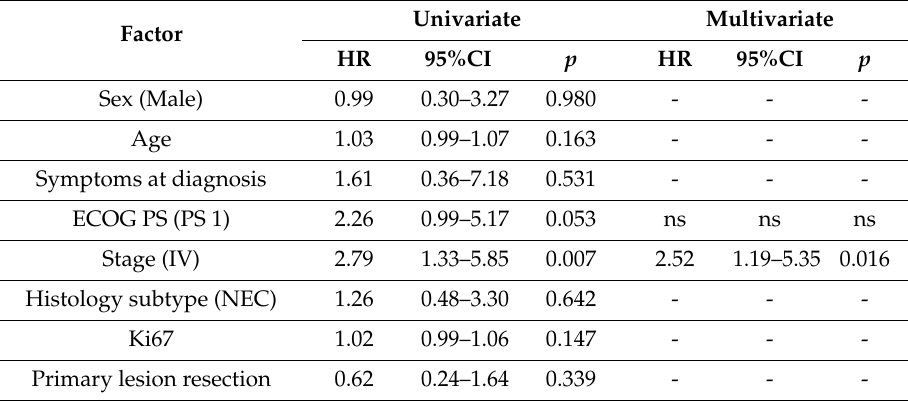
Figure 1. Kaplan–Meier estimates of overall survival (OS) by ( a ) performance status according to ECOG and ( b ) stage at diagnosis. Table 2. Cox proportional hazard models for the risk of